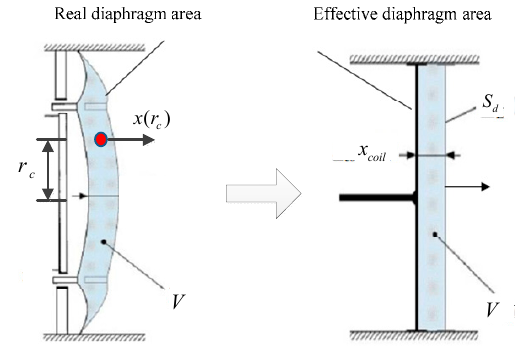
Figure 16. Method for identifying the effective area.